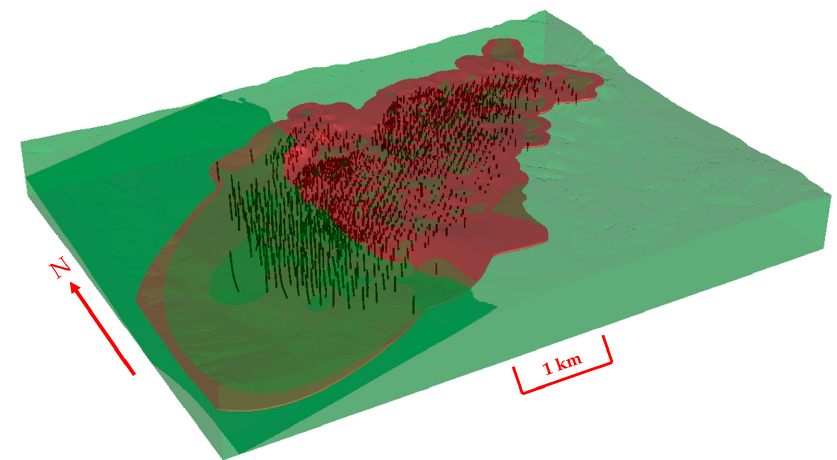
Figure 2. Perspective view of the lenticular and tabular Paracatu orebody (red) within the host phyllite (green). Drillhole traces of all drilling conducted at Paracatu shown in black. Majority of drillhole plunges are subvertical to vertical.